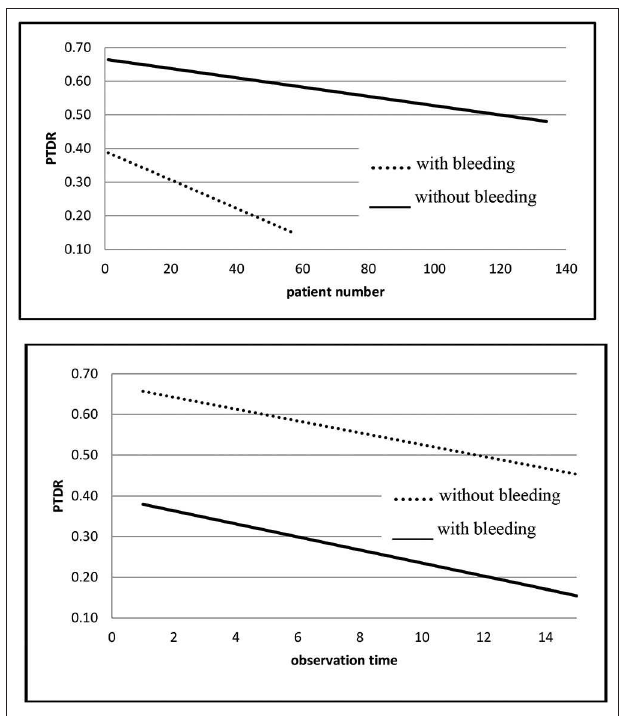
FIGURE 6 | PTDR relationship for patients in groups with and without diagnostic error. FIGURE 7 | PTDR relationship for patients in groups with and without bleeding